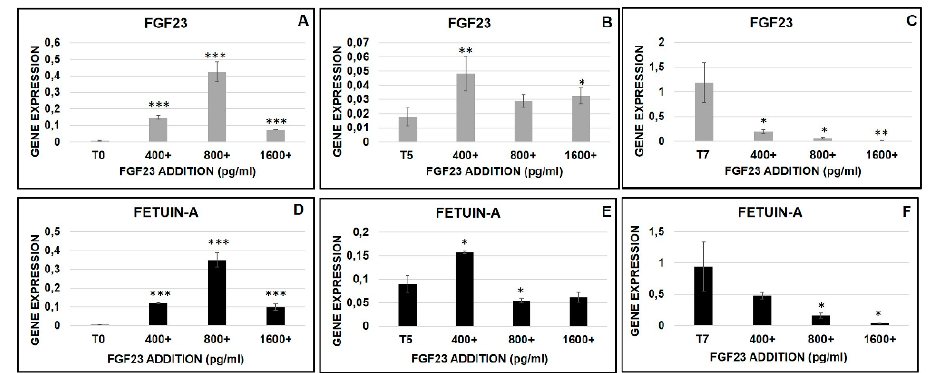
Figure 11. qRT-PCR of FGF23 ( A – C ) and Fetuin-A ( D – F ) 24 h after 400, 800, 1600 pg/ml of FGF23 addition at T0, T5, and T7 during the osteo-induction ( A ). Asterisks indicate significant differences versus M2-10B4 T0, T5, and T7 without induction: * p < 0.05, ** p < 0.01, *** p < 0.001.